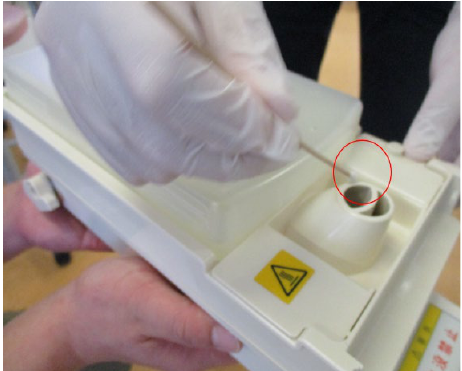
Figure 1. Location where the infection control team members took the environmental culture. The red circle is the tip of a swab. This picture shows the spot where the environmental culture was taken from the humidifier of the incubator (E2). The patient in E2 was fungemia negative.